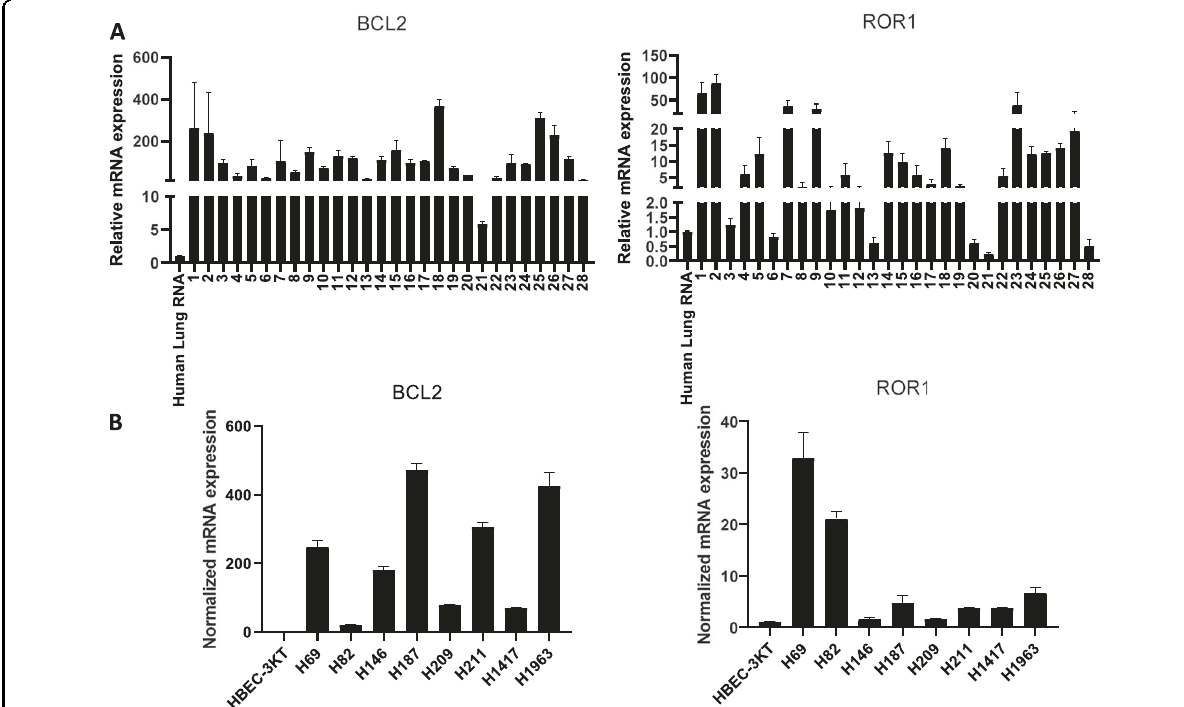
Fig. 2 RT-qPCR analysis of BCL2 and ROR1 expression in SCLC. A Analysis of 28 SCLC FFPE samples with Human Lung RNA used as normal control. B Analysis of 8 SCLC cell lines with HBEC-3KT used as normal control. All gene expression levels were normalized to